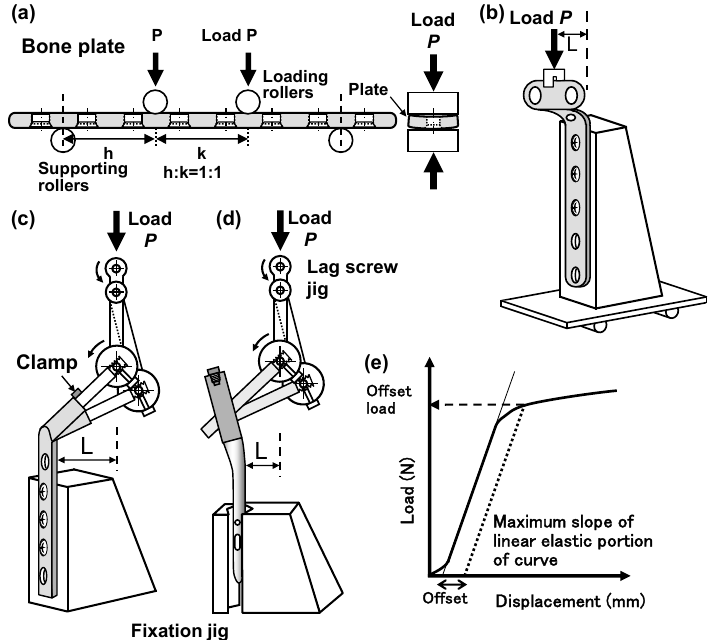
Figure 1. Schematic illustration of ( a ) four-point bending test of bone plates, intramedullary nails, and spinal rods, and ( b – d ) jigs for the compression bending test of metaphyseal plates, compression hip screws (CHSs), and short femoral nails, respectively. ( e ) Load versus displacement (L–D) curve for determining the bending properties from four-point bending test or compression bending test results.